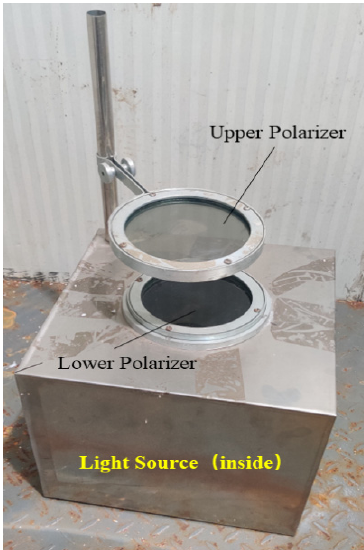
Figure 3. Ice crystal structure observation device.